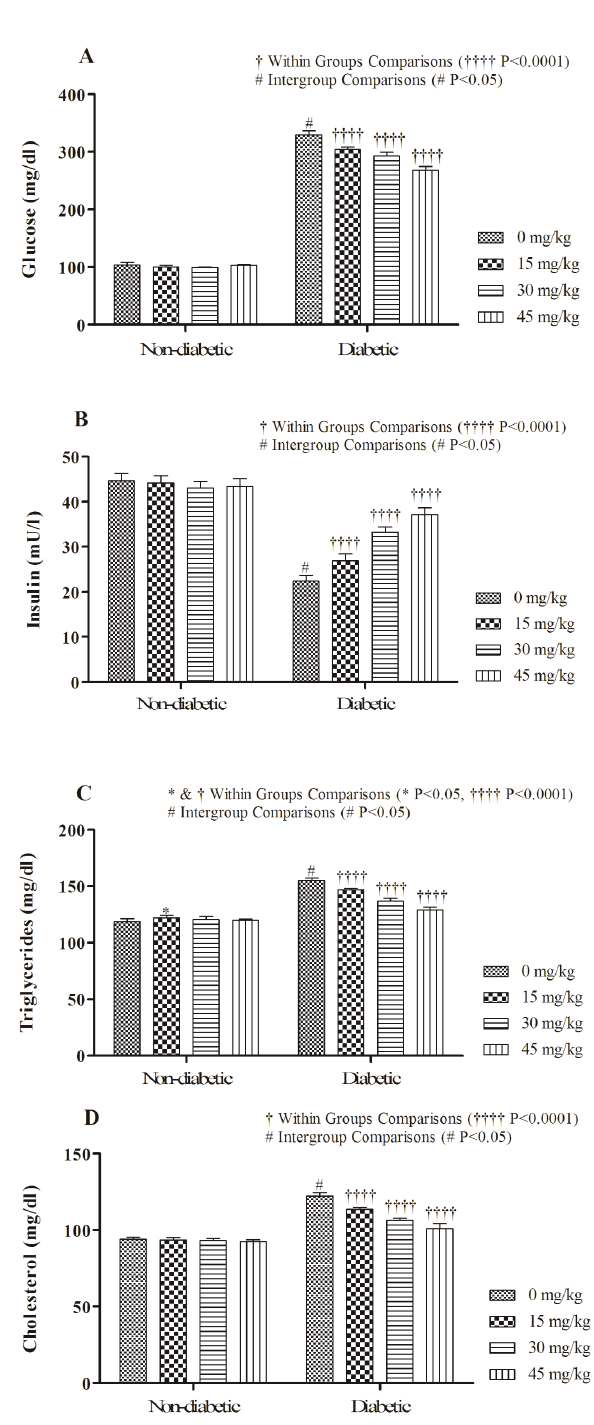
Figure 3. Effects of different levels of SN extract on blood variables in diabetic and non-diabetic rats